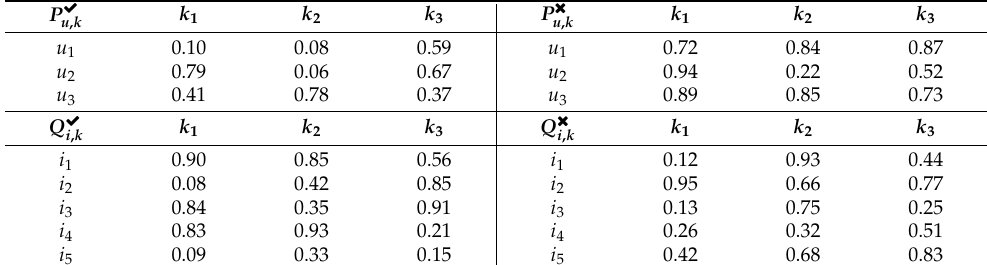
Table 4. Latent factors for both users P and items Q after one iteration.